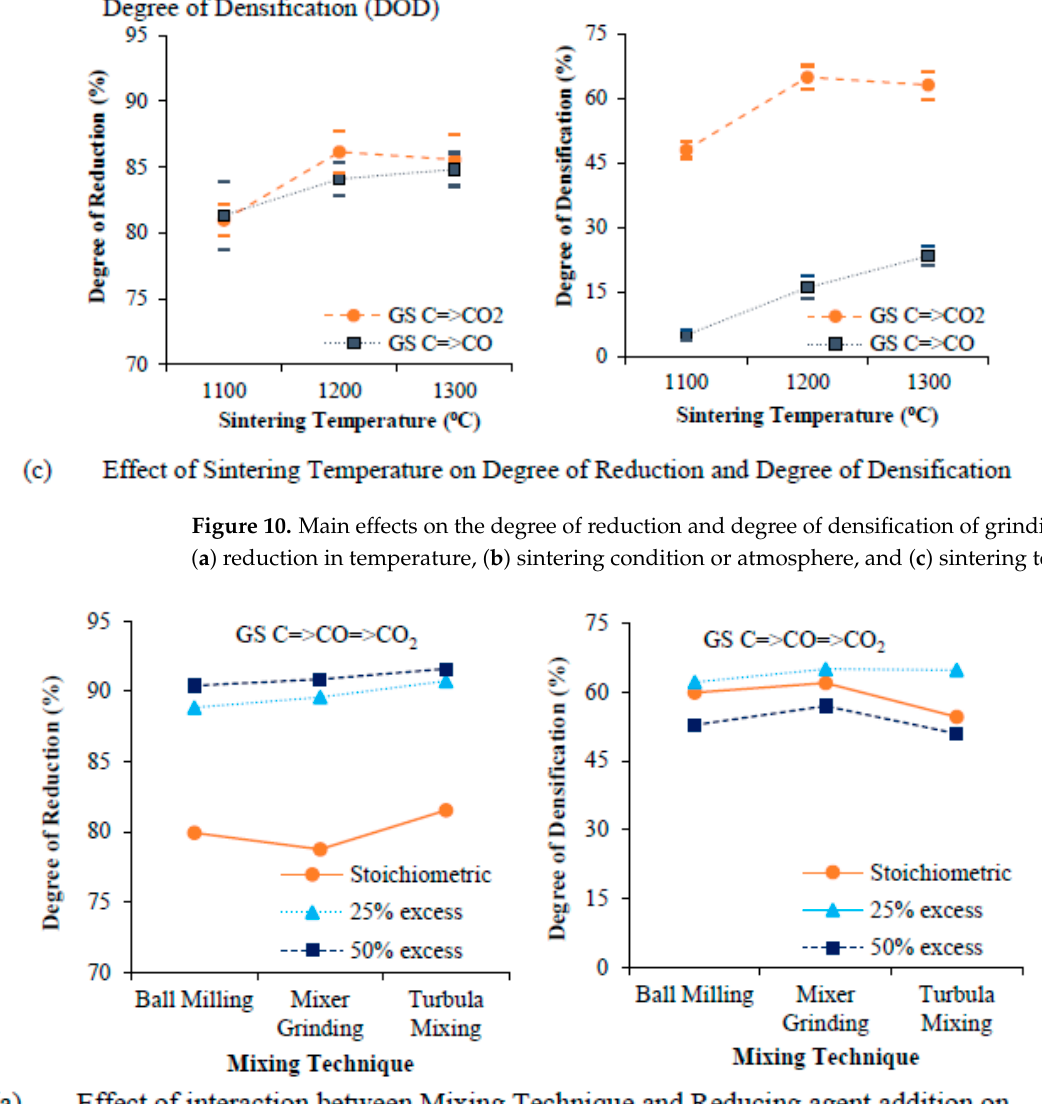
Figure 11. Effect of interaction of material parameters on DOR and DOD.